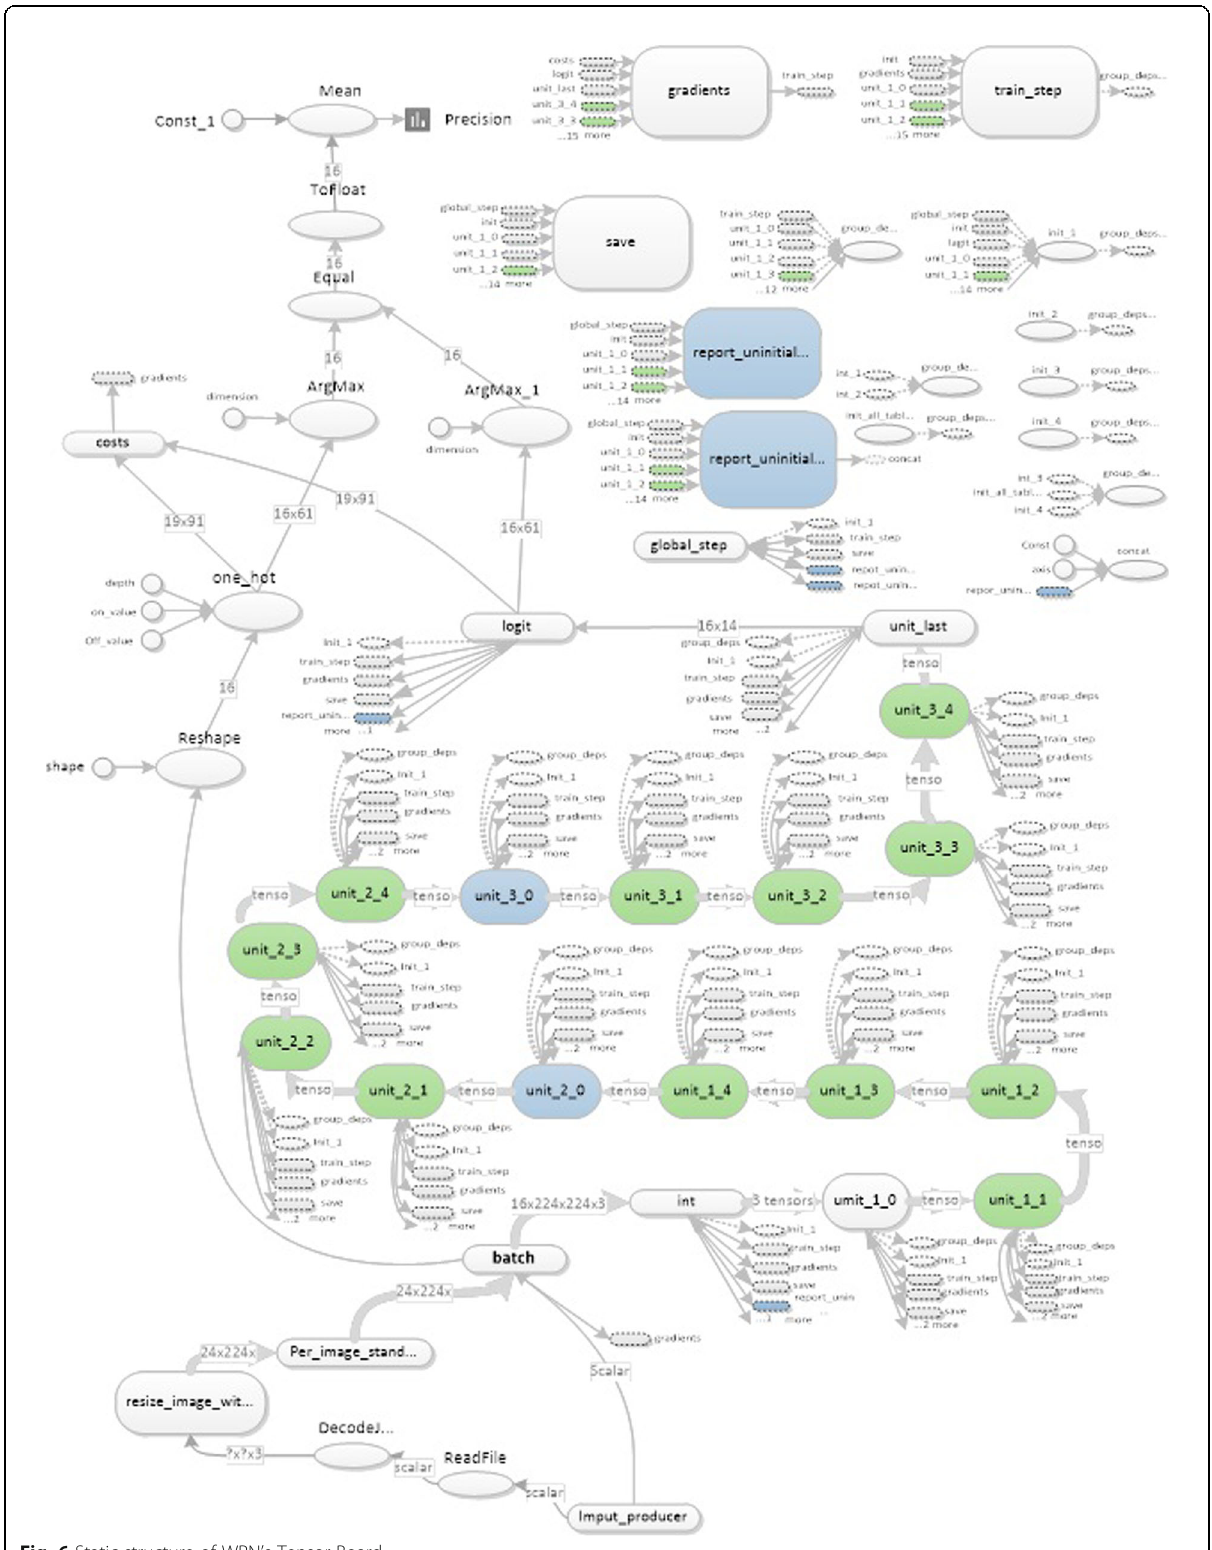
Fig. 6 Static structure of WRN ’ s Tensor